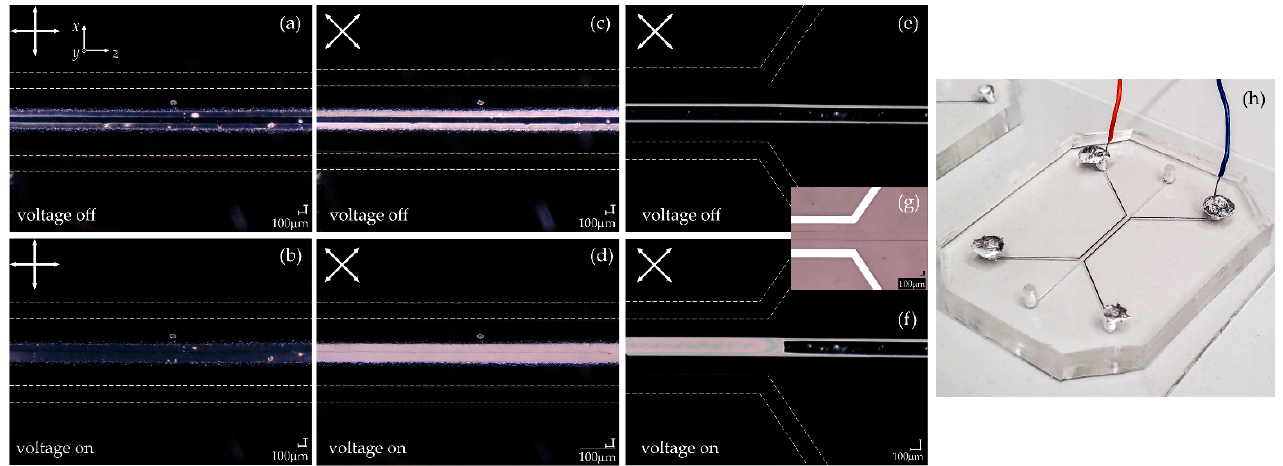
Figure 7. ( a ‒ f ) Change in the molecular orientation obtained in the central liquid crystalline channel due to the electric voltage application through fluid eutectic Ga-In electrodes (in the form of two side channels, the edges of which are marked by the dashed lines in the photographs from the POM). Tests were performed in the PDMS:glass samples fabricated by photostencil film processing, h/w ≈ 1 ( a ‒ d ) and SU-8 photolithography, h/w ≈ 0.15 ( e , f ). More details about the liquid crystalline materials and voltages applied may be found in the text above. ( g ) Photograph of the part of the structure taken with reflected illumination, demonstrating the sample geometry (with the side channels infiltrated with EGaIn). ( h ) Photograph of the actual PDMS:glass system with two additional electric wires allowing for the electric biasing of the sample.